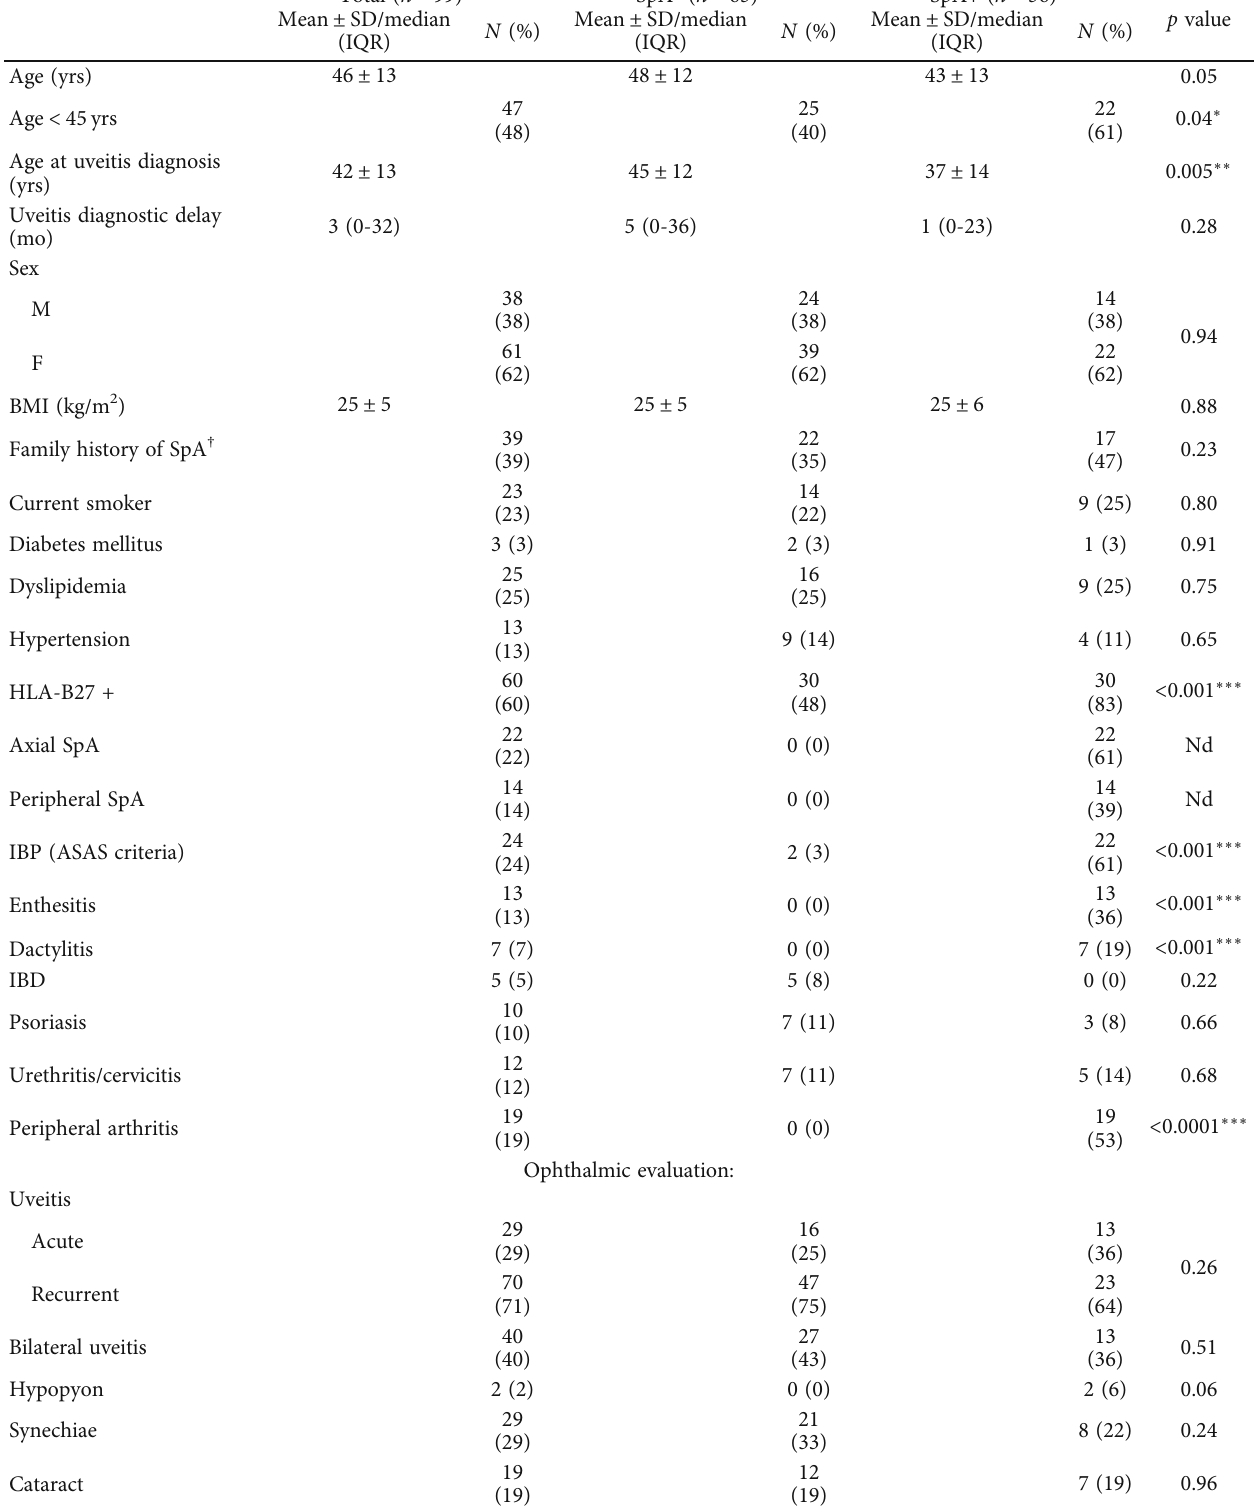
Table 1: Main characteristics of study population according to SpA